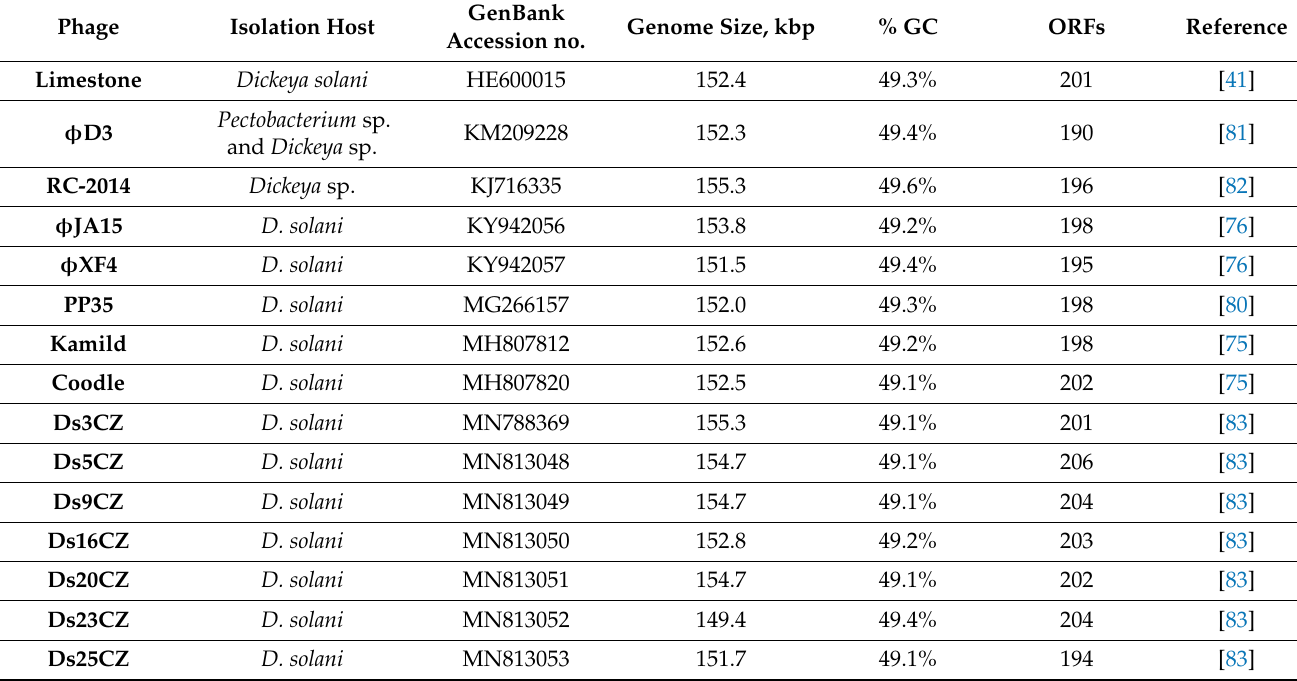
Table 1. Genomic properties of Ackermannviridae bacteriophages infecting